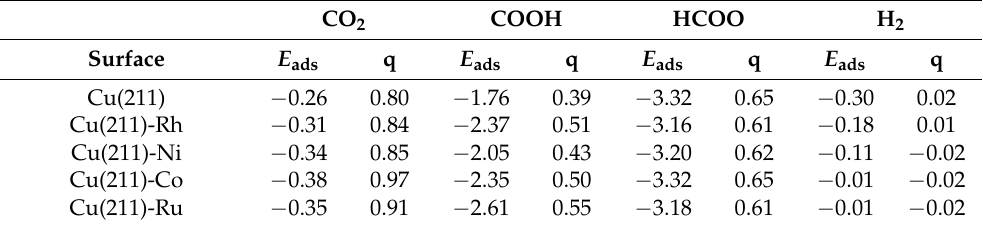
Table 2. Adsorption energies ( E ads , eV) and net Bader charges (q, e) of CO 2 , COOH, HCOO, and H